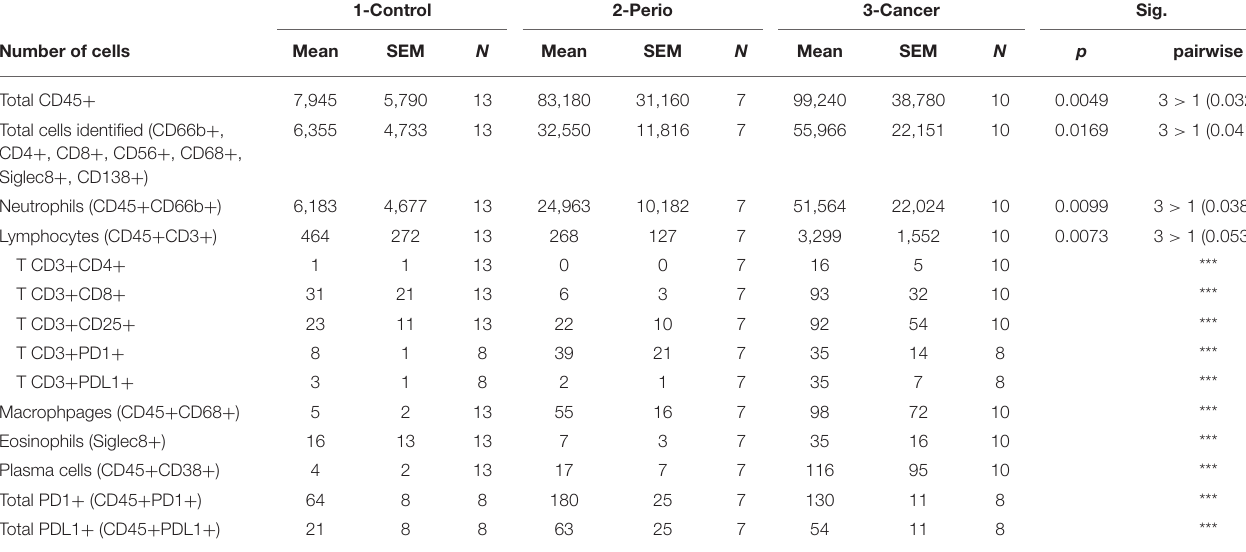
TABLE 4 | Distribution of salivary immune cells (numbers).